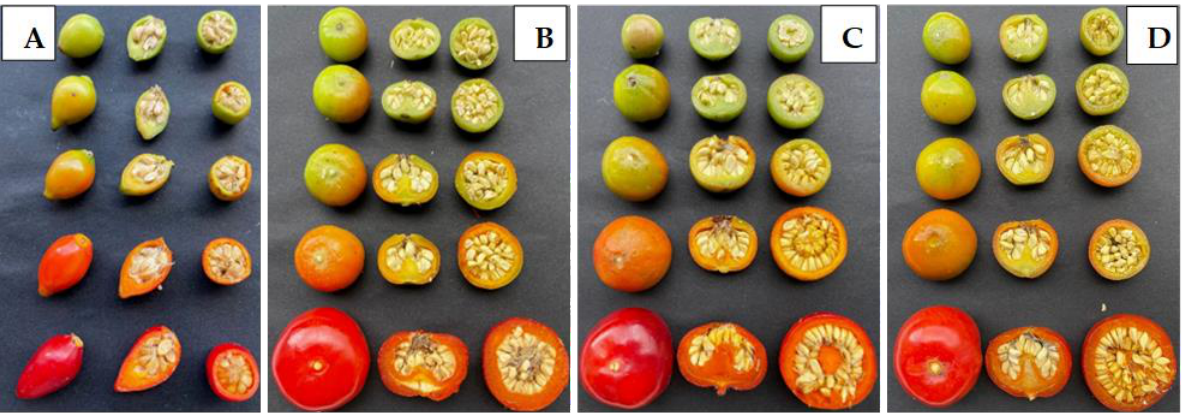
Figure 1. Fruit ripening stages of Rosa samples, ( A ) — Rosa canina , ( B ) — Rosa rugosa , ( C ) — Rosa rugosa ‘Rubra’ , ( D ) — Rosa rugosa ‘Alba’ (photos by B. Medveckienė) .